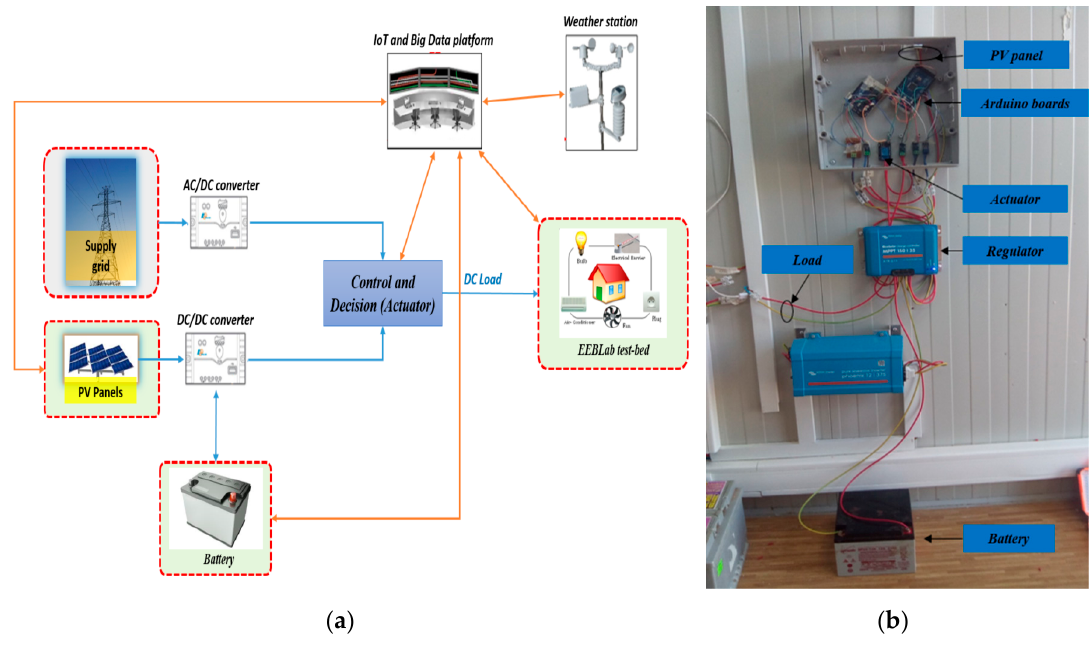
Figure 2. ( a ) Block diagram of the MG system; ( b ) the deployed prototype in our EEBLab test-bed.